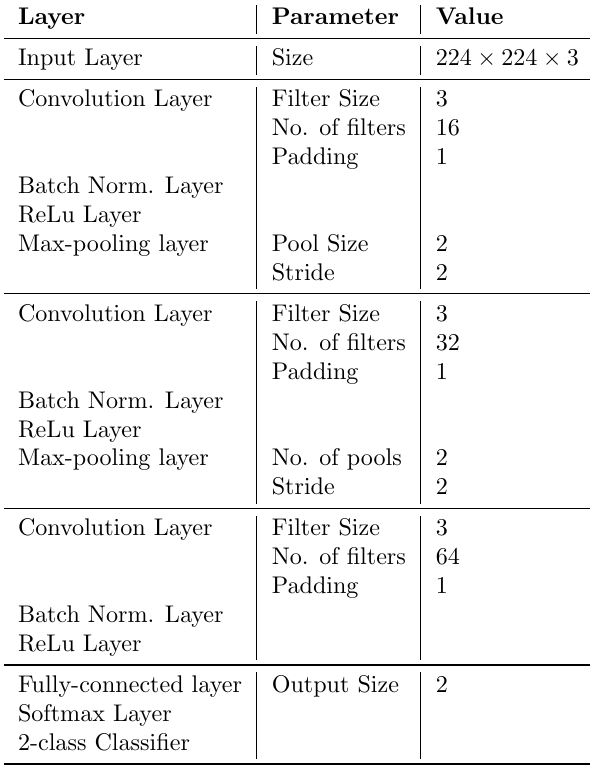
Table 1: CNN Structure and layer parameters. (SGDM) optimizer. Using 100 epochs and an initial learning rate of 0 . 00001, the final validation accuracy was